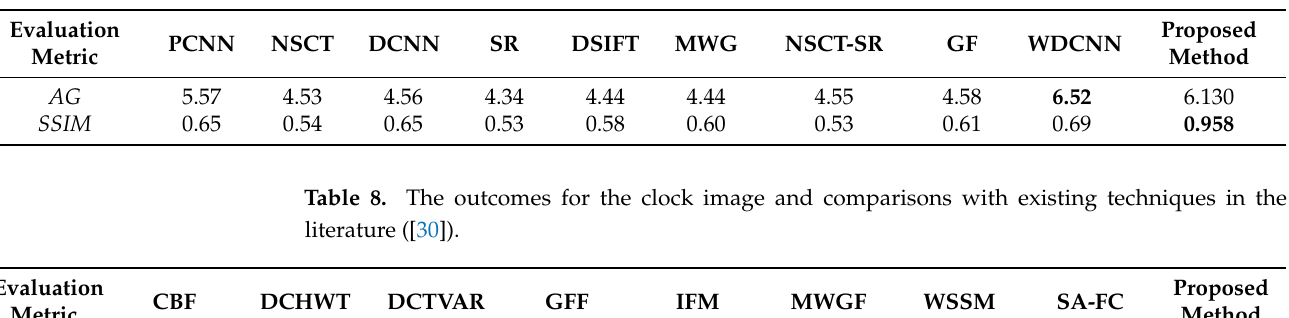
Table 7. The outcomes for the clock image and comparisons with existing techniques in the literature ([28]).